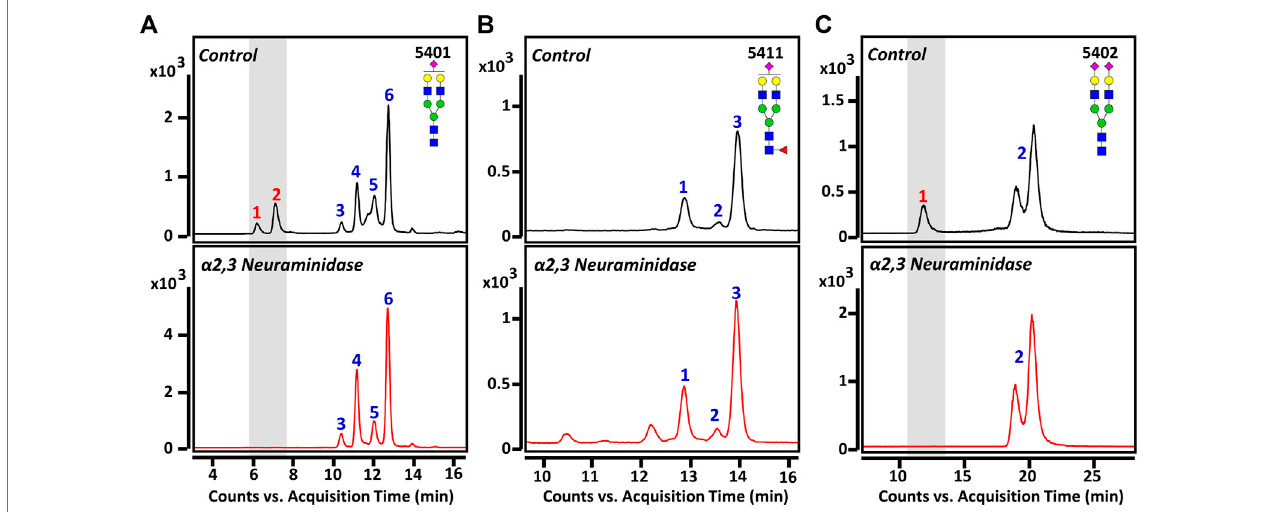
FIGURE4| Monitoring ofsialylatedglycan isomers beforeand after exo-glycosidasedigestion: (A) Hex 5 HexNAc 4 NeuAc 1 , (B) Hex 5 HexNAc 4 Fuc 1 NeuAc 1 ,and (C) Hex 5 HexNAc 4 NeuAc 2 . The top panels indicate before treatment and bottom panels show after treatment with α 2,3 neuraminidase for 3 h at 37 ° C, respectively. Chromatographicpeaksreducedbyenzymatictreatmentarehighlightedingraywindows.Fortheglycancartoons,greencirclesdenotemannose,yellowcirclesdenote galactose, blue squares denote N -acetylglucosamine, red triangles denote fucose, and purple diamonds denote N -acetylneuraminic